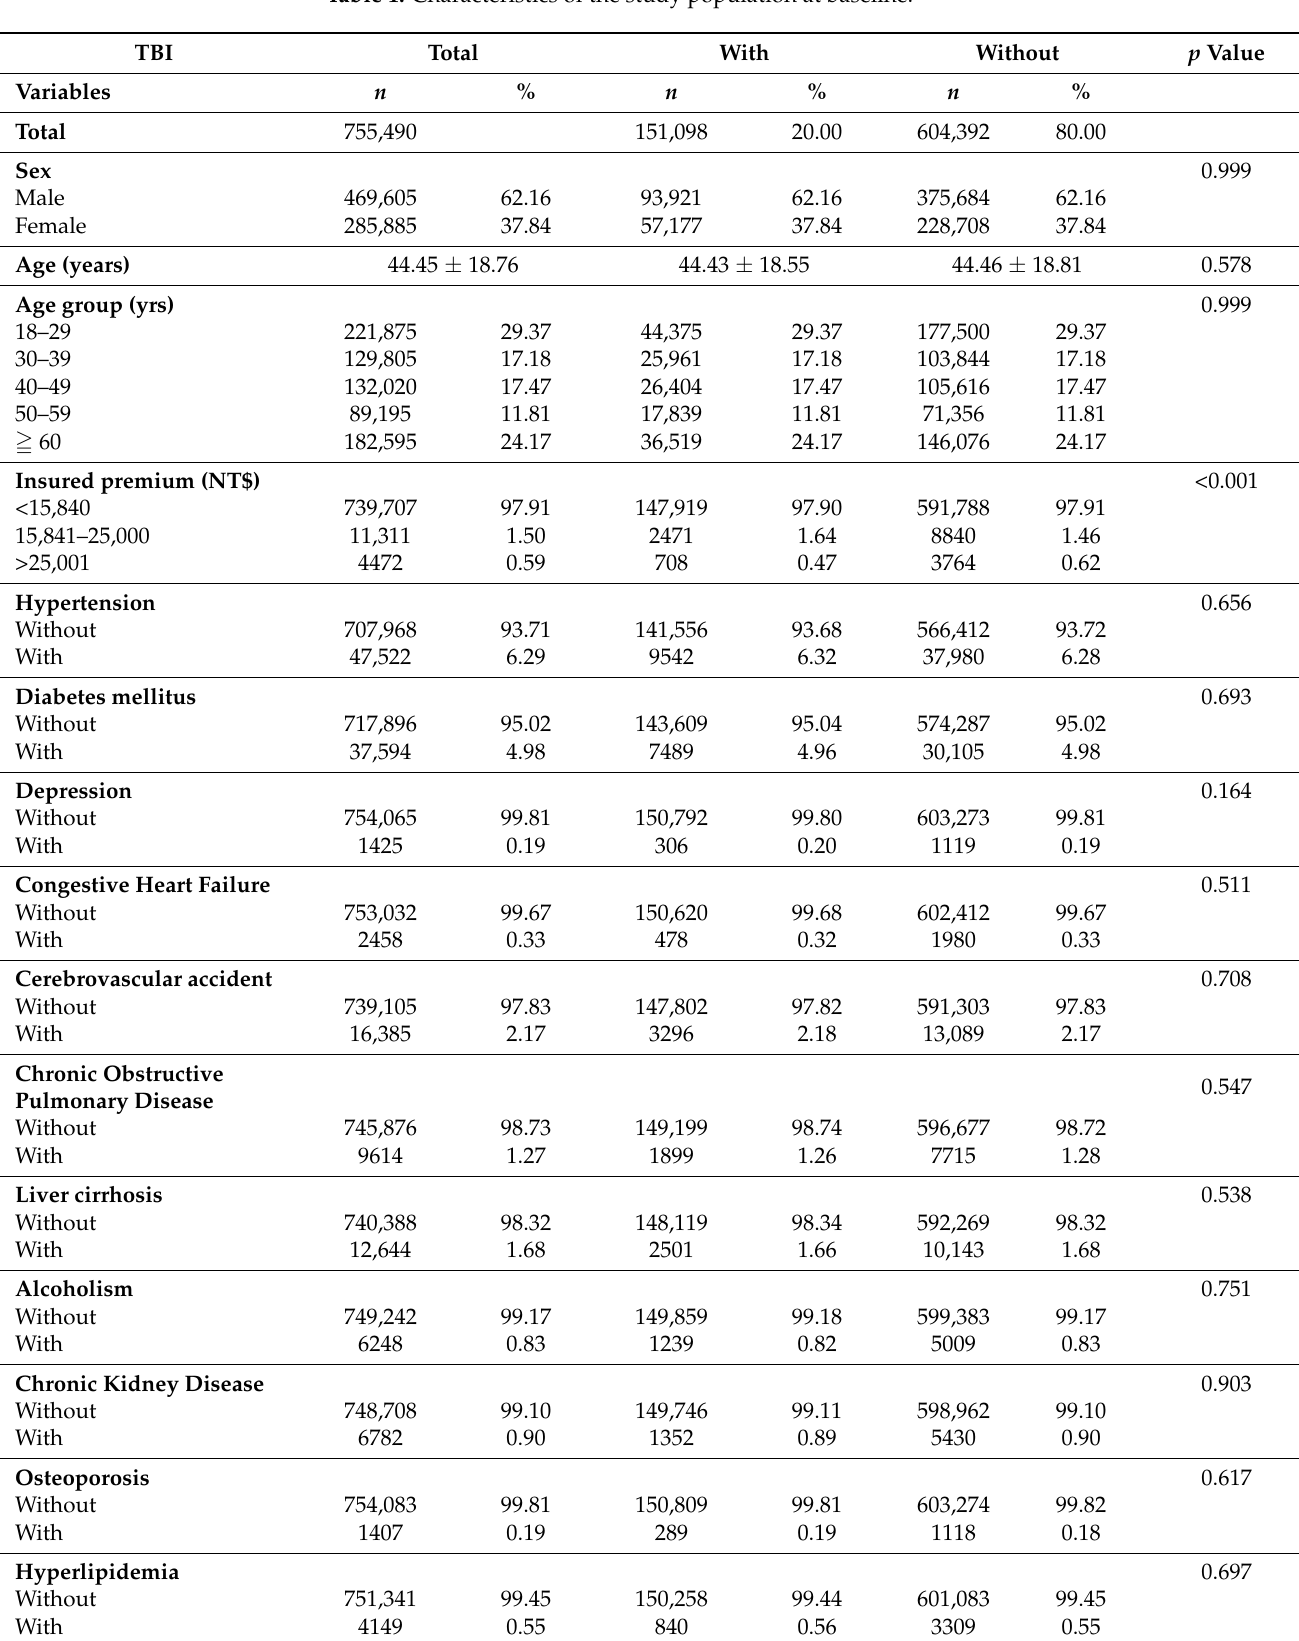
Table 1. Characteristics of the study population at